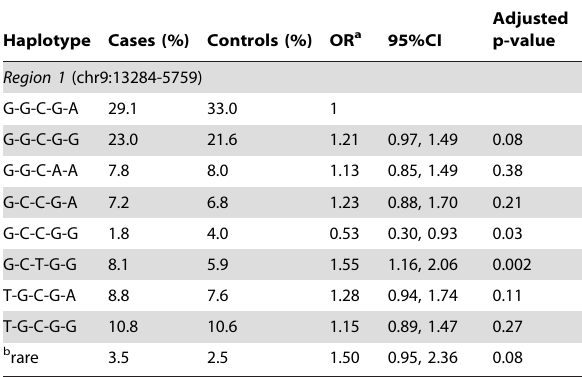
Table 4. ALAD Haplotype Association and Renal Cancer Risk.